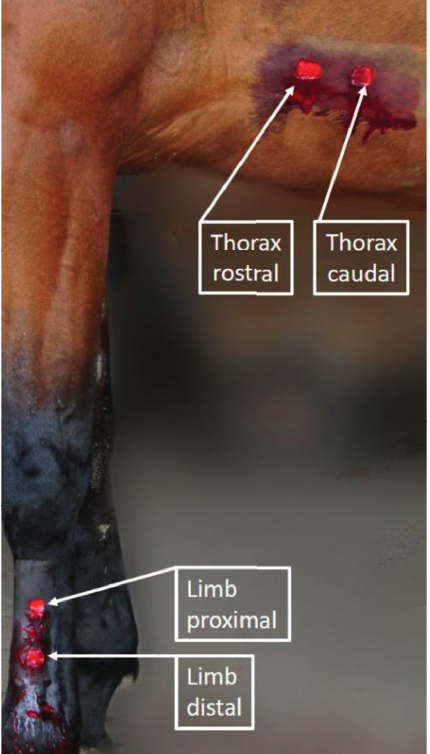
Figure 2: Experimental design. Two wounds were created on both FL and the TH 30cm behind the tip of the elbow on a balanced horse. Treatment application was randomized in terms of right or left side, cranial-caudal (TH), or proximal-distal (FL) wound assignment. The four treatments (OM-MSC or its secretome embedded in an HA-gel, HA-gel alone, or no treatment) were applied daily two (G1) or four (G2) times, starting 24 hours after wound